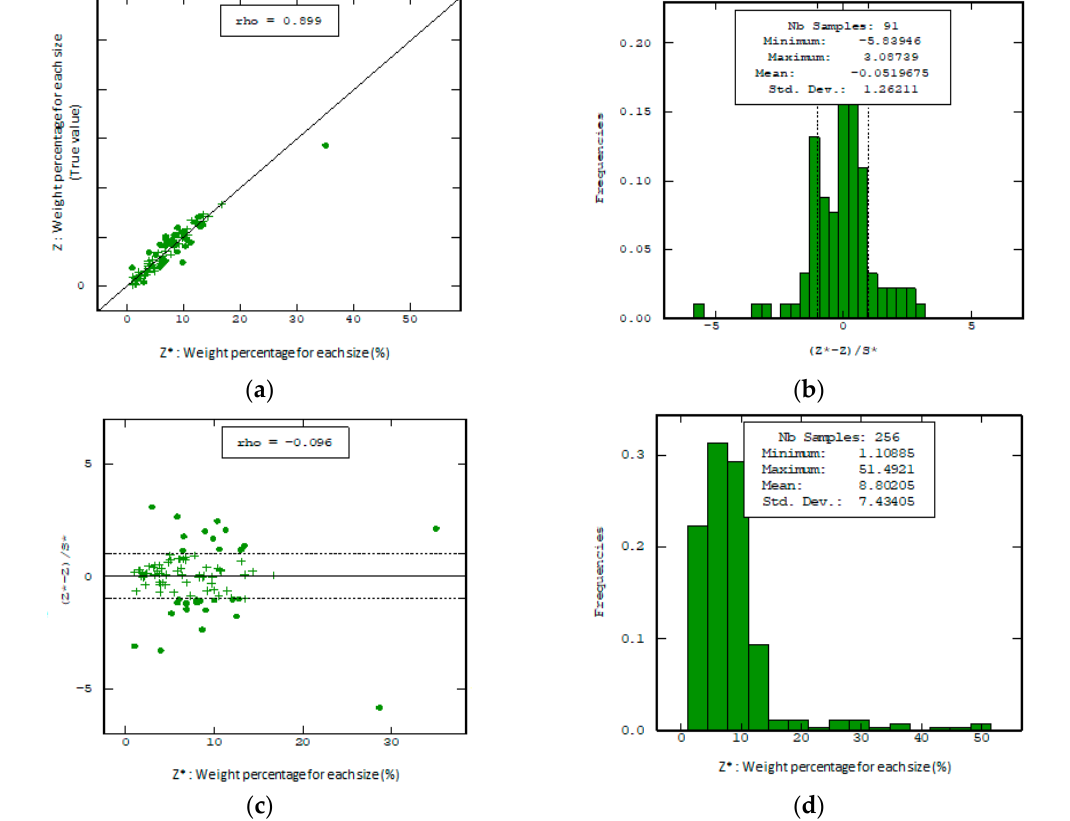
Figure A5. Cross-evaluation of the geostatistical analysis of LGP-2 with ore-A. ( a ) Scatter plot (identity line) where the x-axis represents the modeled data, and the y-axis represents the experimental data. ( b ) Standardized error histogram. ( c ) Standardized error based on the estimated value. ( d ) Histogram and its statistical parameters of the estimated data.